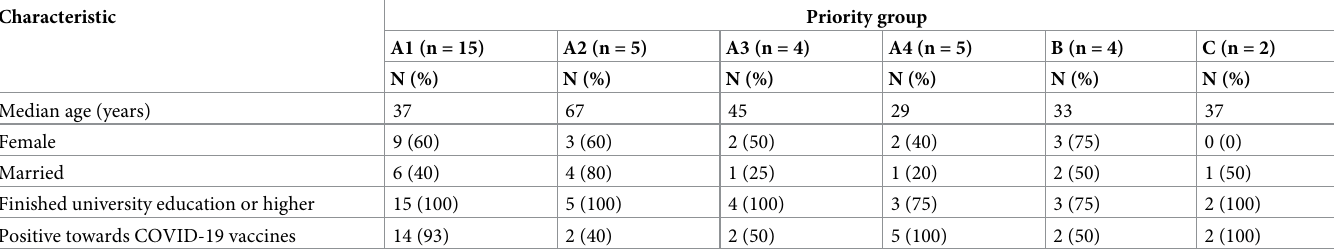
Table 2. Characteristics of interview